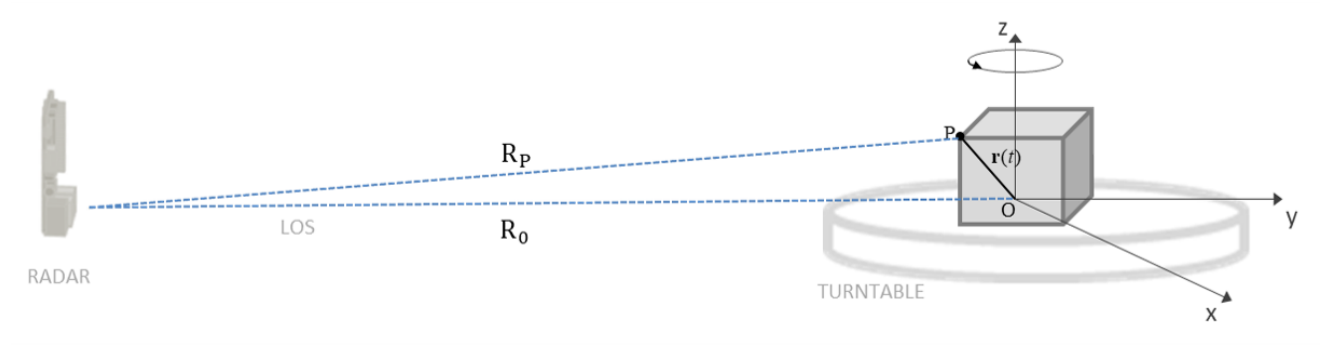
Figure 1. Observation geometry of an object rotating by means of a